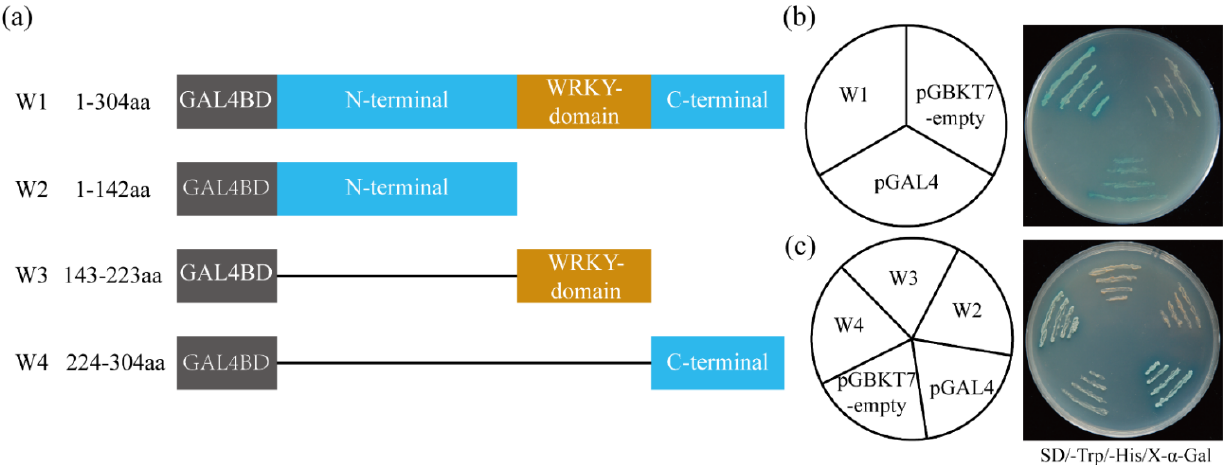
Figure 4. The transcriptional activity of ItfWRKY70 in yeast. ( a ) Schematic diagrams of multiple truncated ItfWRKY70 constructions for transactivation assay in yeast cells. W1, the full length of ItfWRKY70; W2, N-terminal of ItfWRKY70 with 142 amino acid residues; W3, WRKY domain of ItfWRKY70 with 80 amino acid residues; W4, C-terminal of ItfWRKY70 with 80 amino acid residues. ( b ) Transactivation activity assay of full-length in yeast. ( c ) Transactivation activity assay of different ItfWRKY70 mutants in yeast. The pGBKT7 empty vector and pGAL4 were used as negative and positive controls, respectively.